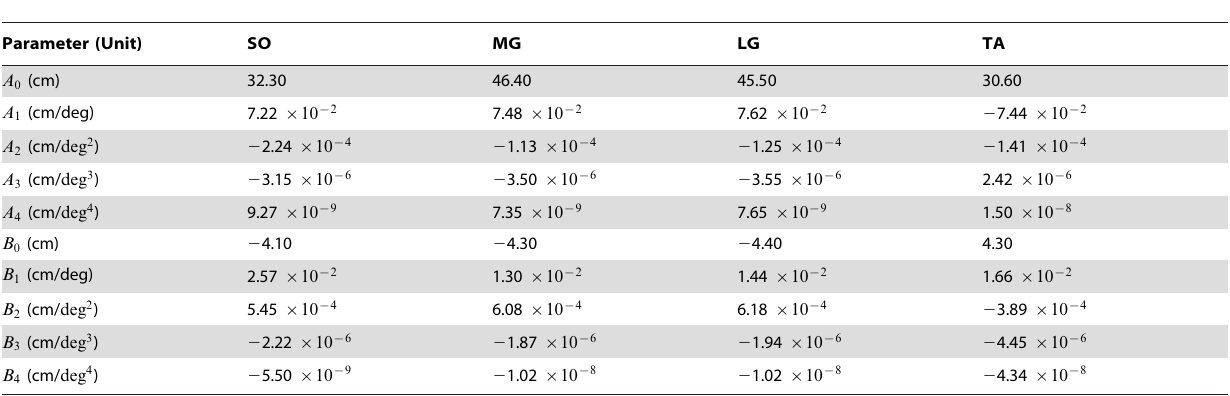
Table 4. Coefficients of equations (8) and